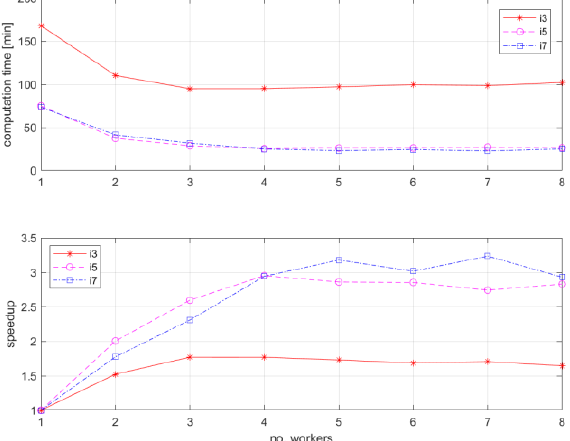
Fig. 1. Graphical representation of computation time and speedup for different number of